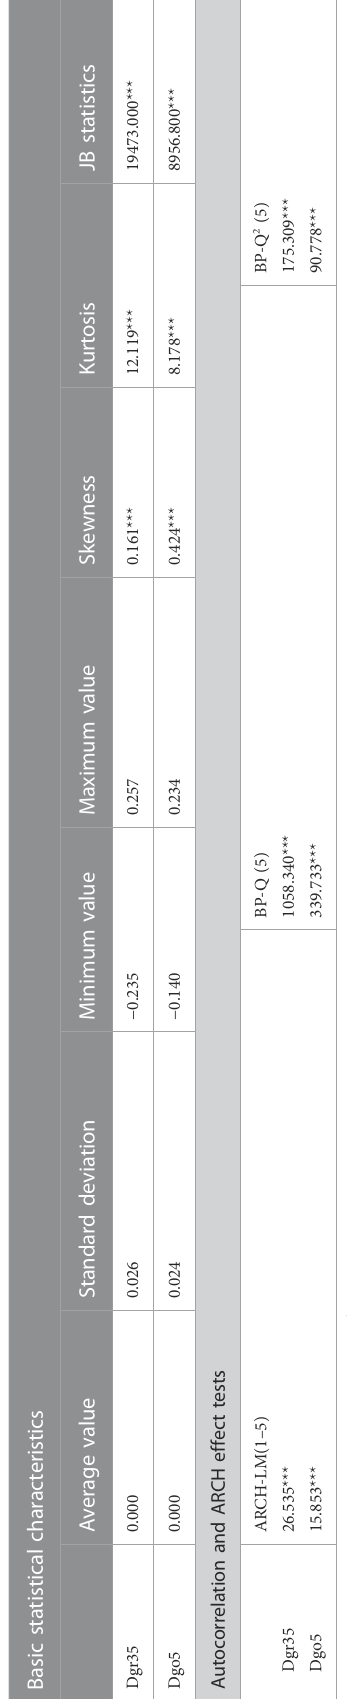
upper and lower